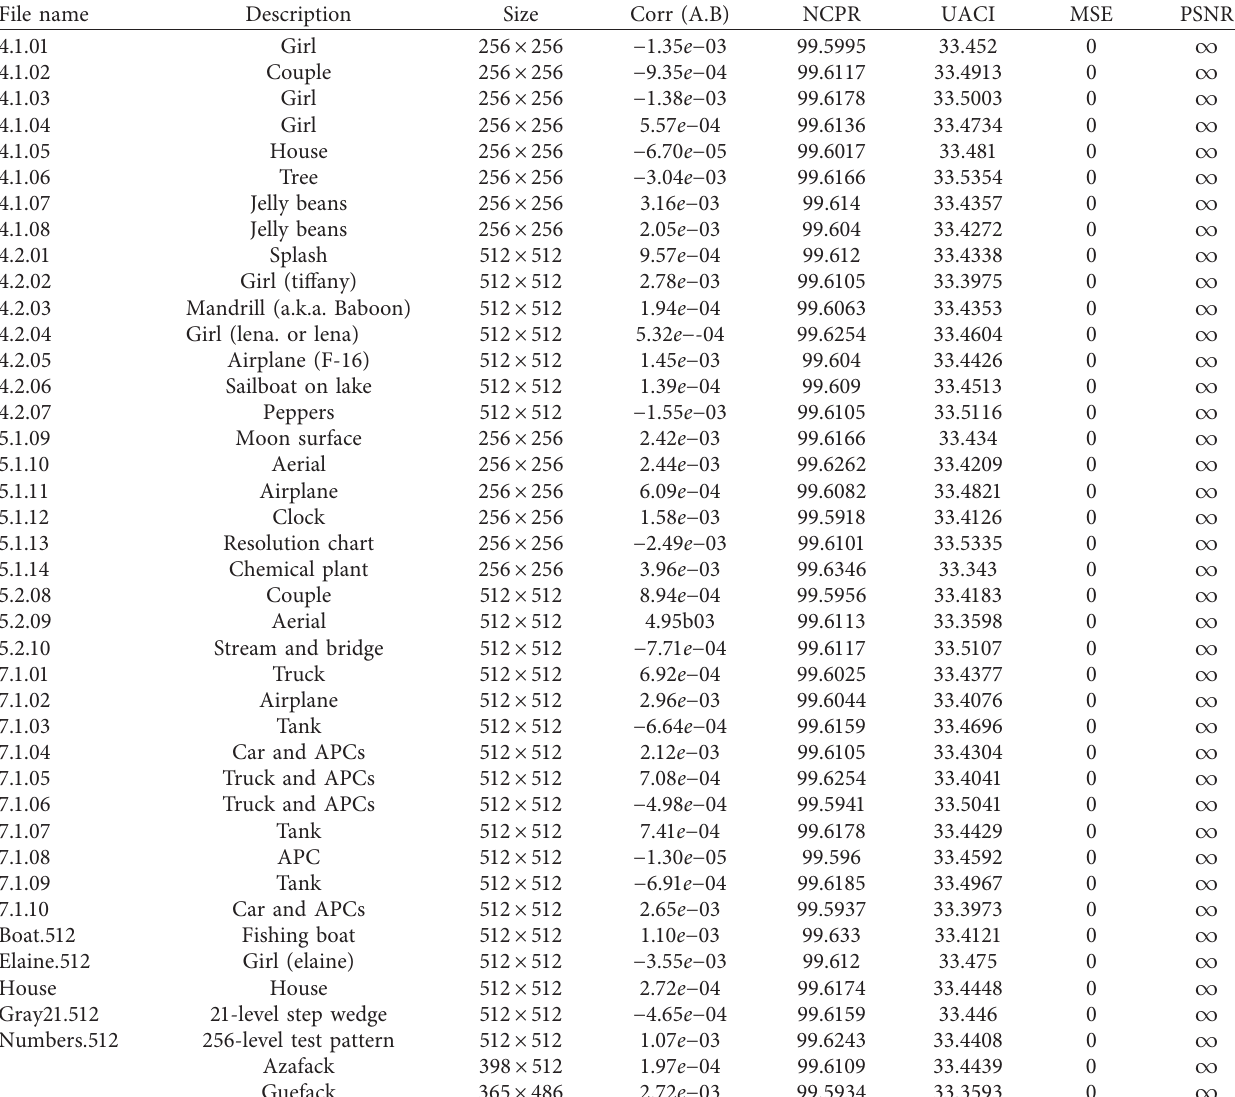
Table 11: Values of the number of pixels’ change rate (NPCR) and unified average changing intensity (UACI) in several nonmedical images.